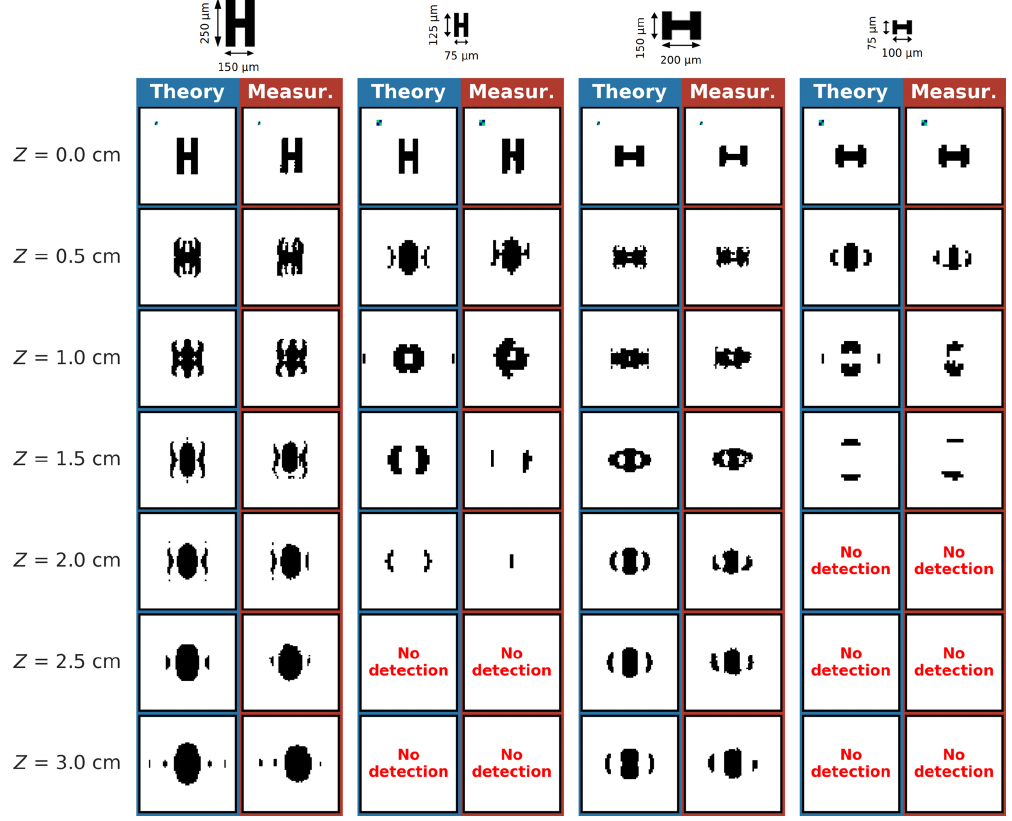
Figure 7. As Fig. 5 for opaque capped columnar planar shape particles: 250 × 150µm (external edges) with 50 × 50µm mid-column, 125 × 75µm with 25 × 25µm mid-column, 150 × 200µm with 50 × 100µm mid-column, and 75 × 100µm with 25 × 50µm mid-column.